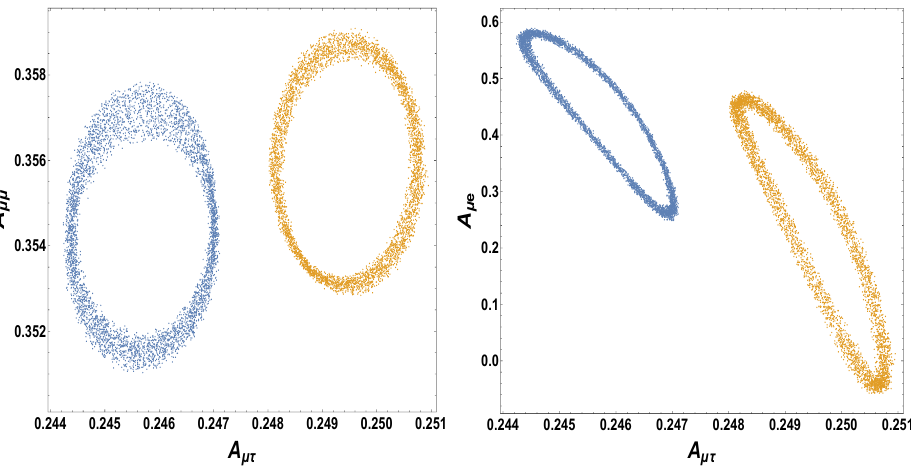
Figure 5. Numerical evaluation of the SM asymmetries of Equation (22) at DUNE, with standard flux. The SM parameters have been allowed to vary in their 1 σ range, while all possible values for the CP phase have been taken into account. The blue dots represent asymmetries in the normal hierarchy hypothesis; the orange ones represent asymmetries in the inverted hierarchy